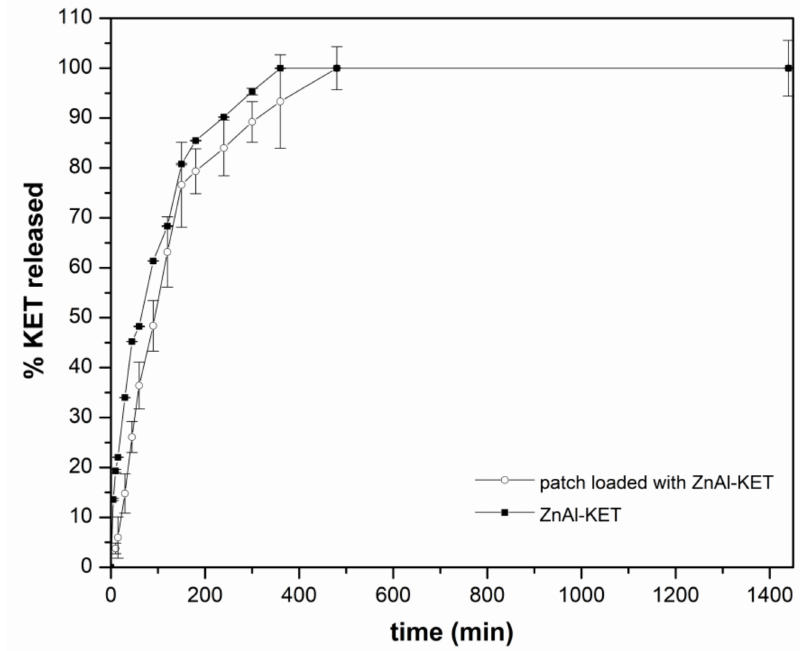
Figure 8. The release profile of KET from ZnAl-KET and from the patch loaded with ZnAl-KET ( p <